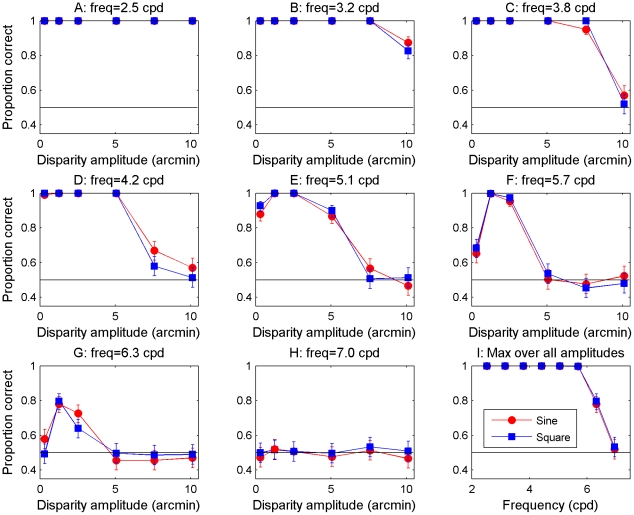
Model results with the quadratic size-disparity correlation.Legend: Model performance on the grating detection task as a function of amplitude and frequency. The last plot (I) shows the maximum performance over all amplitudes for each frequency. This is for the model with the template matching decision model with known frequency and a quadratic size-disparity relationship (Equation 2).